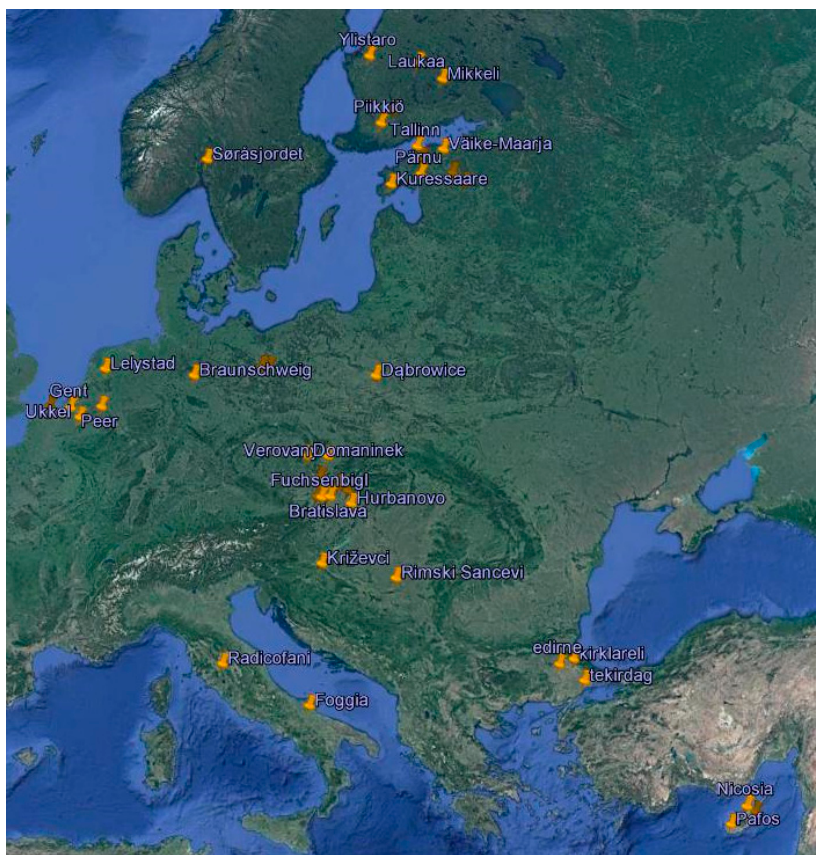
Figure 1. Location of different meteorological stations across Europe.